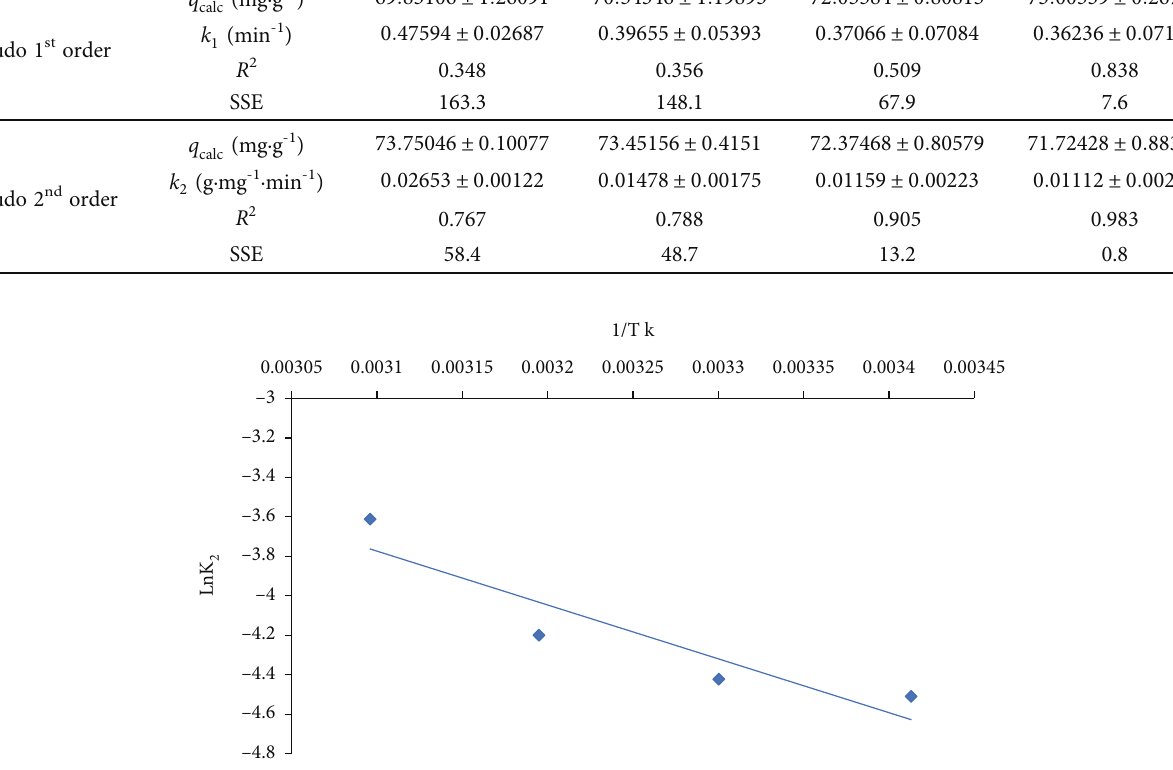
Figure 10: Plot of LnK